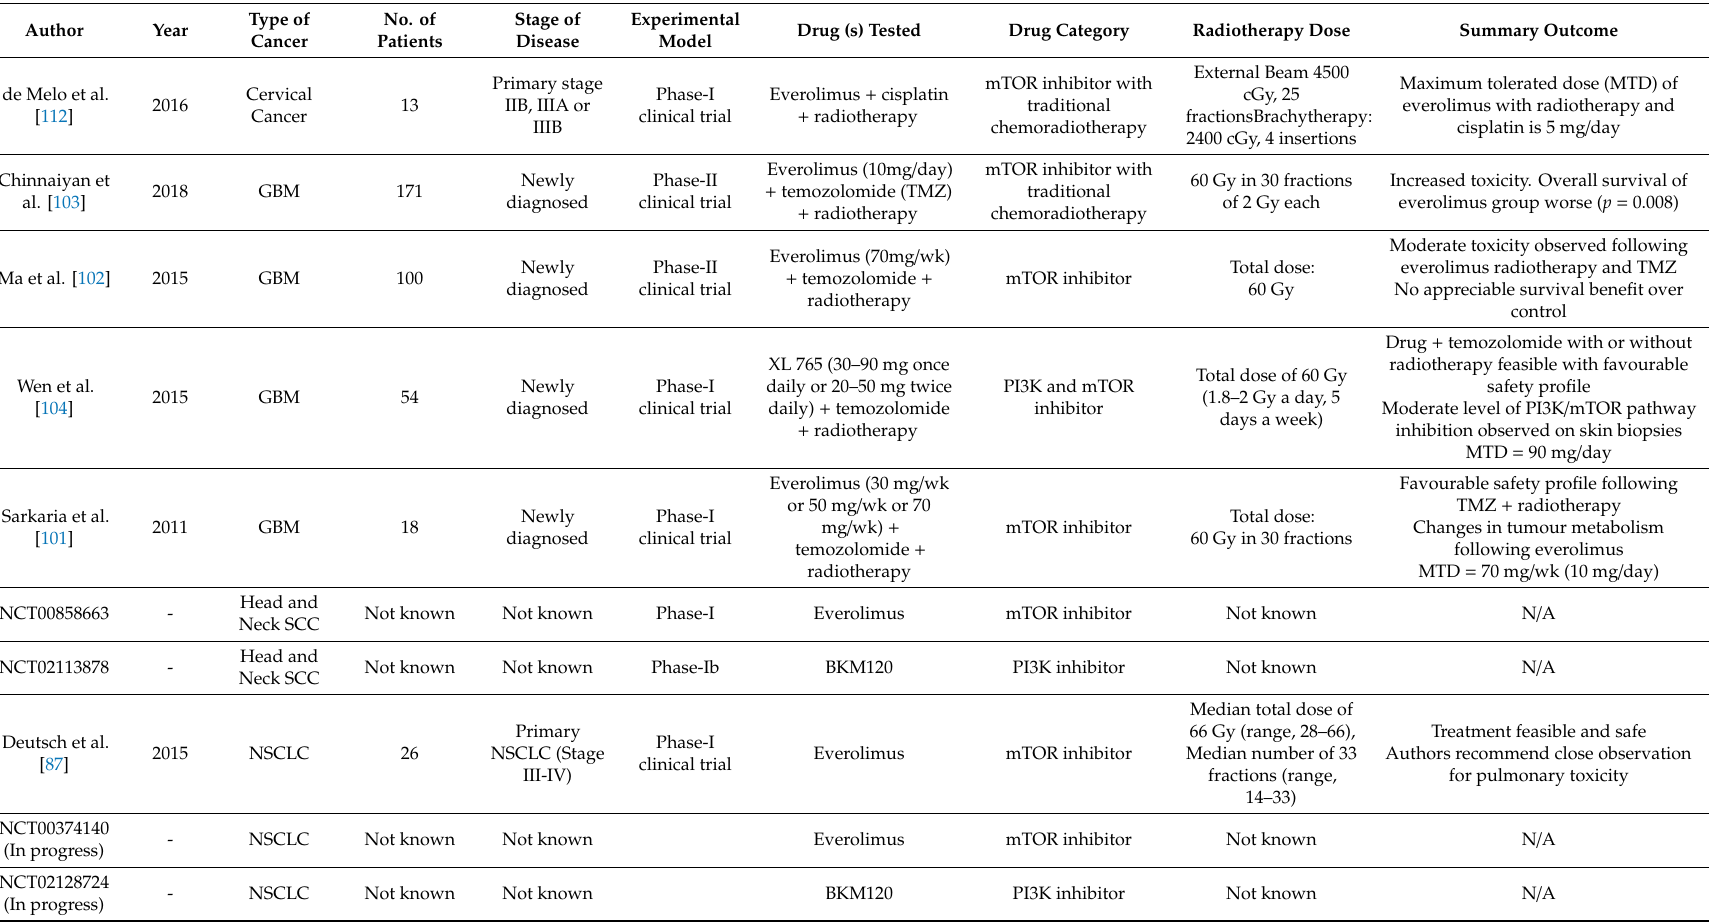
Table 5. Clinical trials exploring the role of PI3K, AKT and / or mTOR inhibitors radiosensitising various